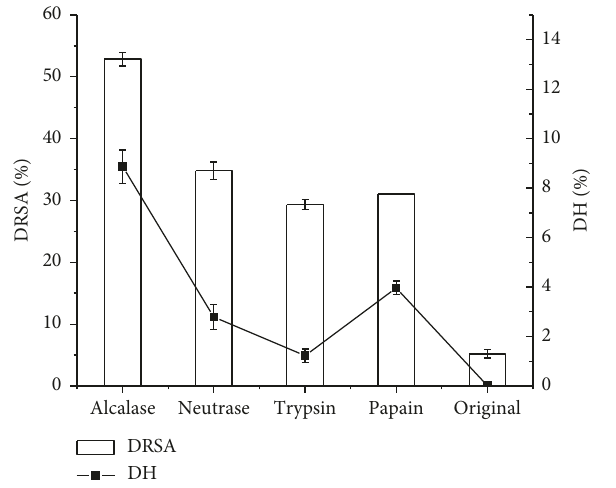
Figure 1: The DRSA and DH of CSPH prepared by different proteases. Error bars represent mean and SD from triplicate experiments.